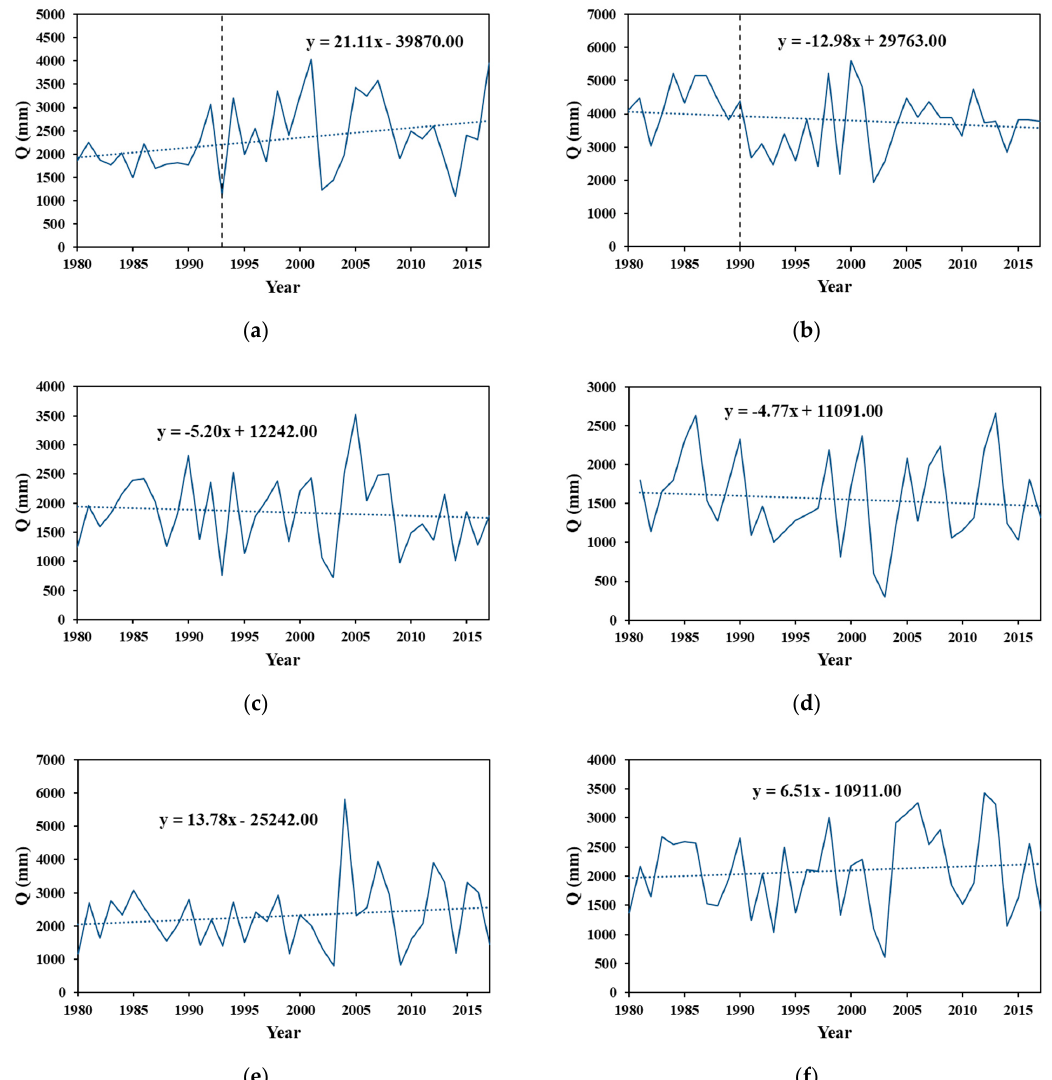
Figure 4. The trend of annual streamflow in northern Taiwan during 1980~2017. ( a ) Lanyang River Basin. ( b ) Keelung River Basin. ( c ) Dahan River Basin. ( d ) Fengshan River Basin. ( e ) Youluo River Basin. ( f ) Shangping River Basin. Table 3. Trend analysis and break point analysis.